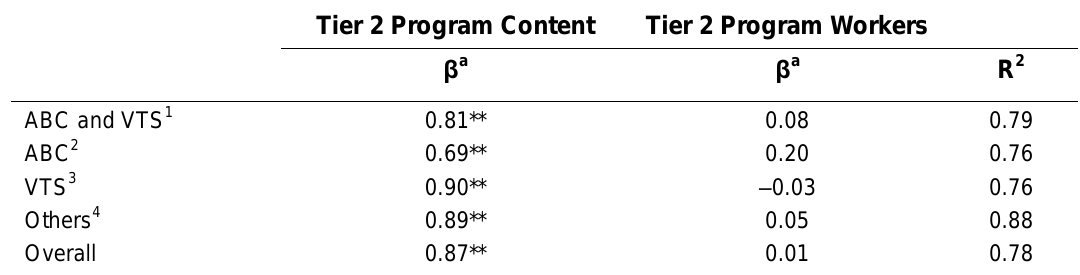
Multiple Regression Analyses Predicting Positive Views towards the Tier 2 Program